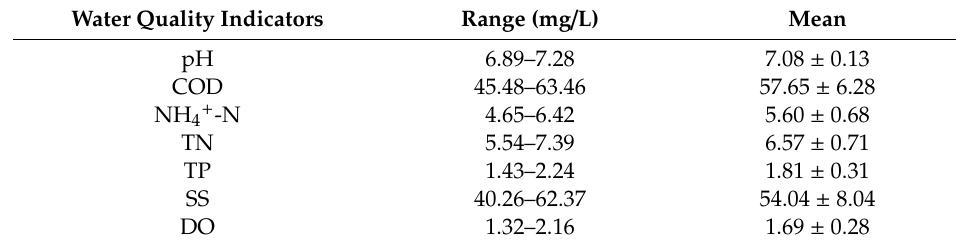
Table 1. Results of water quality monitoring in the study area of the Yitong River.